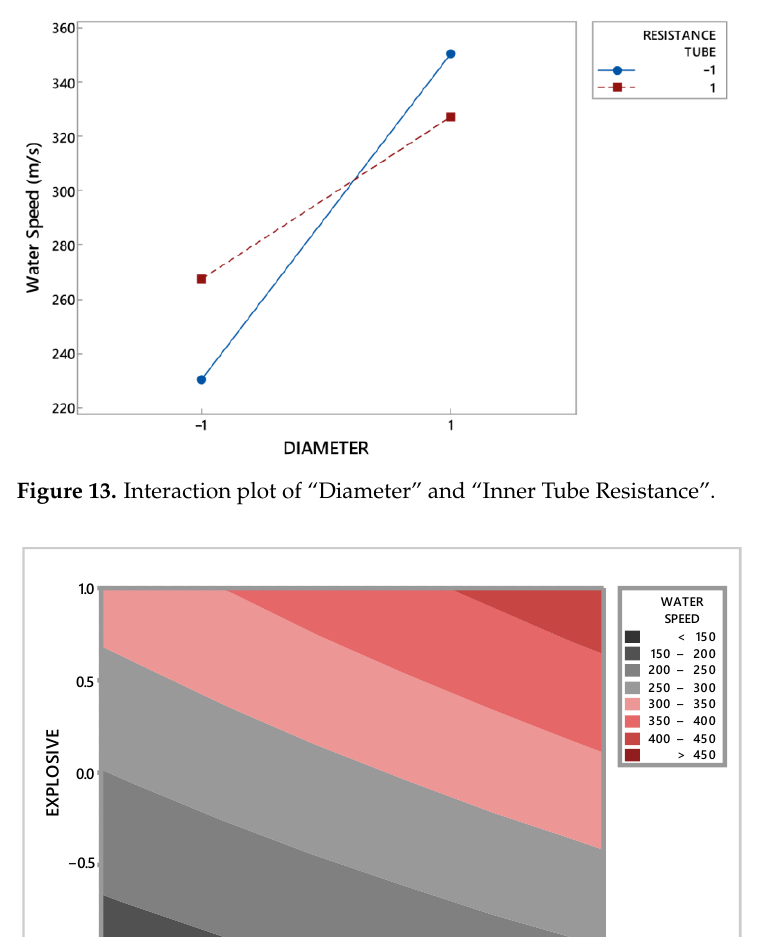
Figure 12. Left : Main effects p lot for the “Diameter” and “ ass of E xplosive” effects. Right : Inter- action plot of “ ass of xplosive” and “Density”.